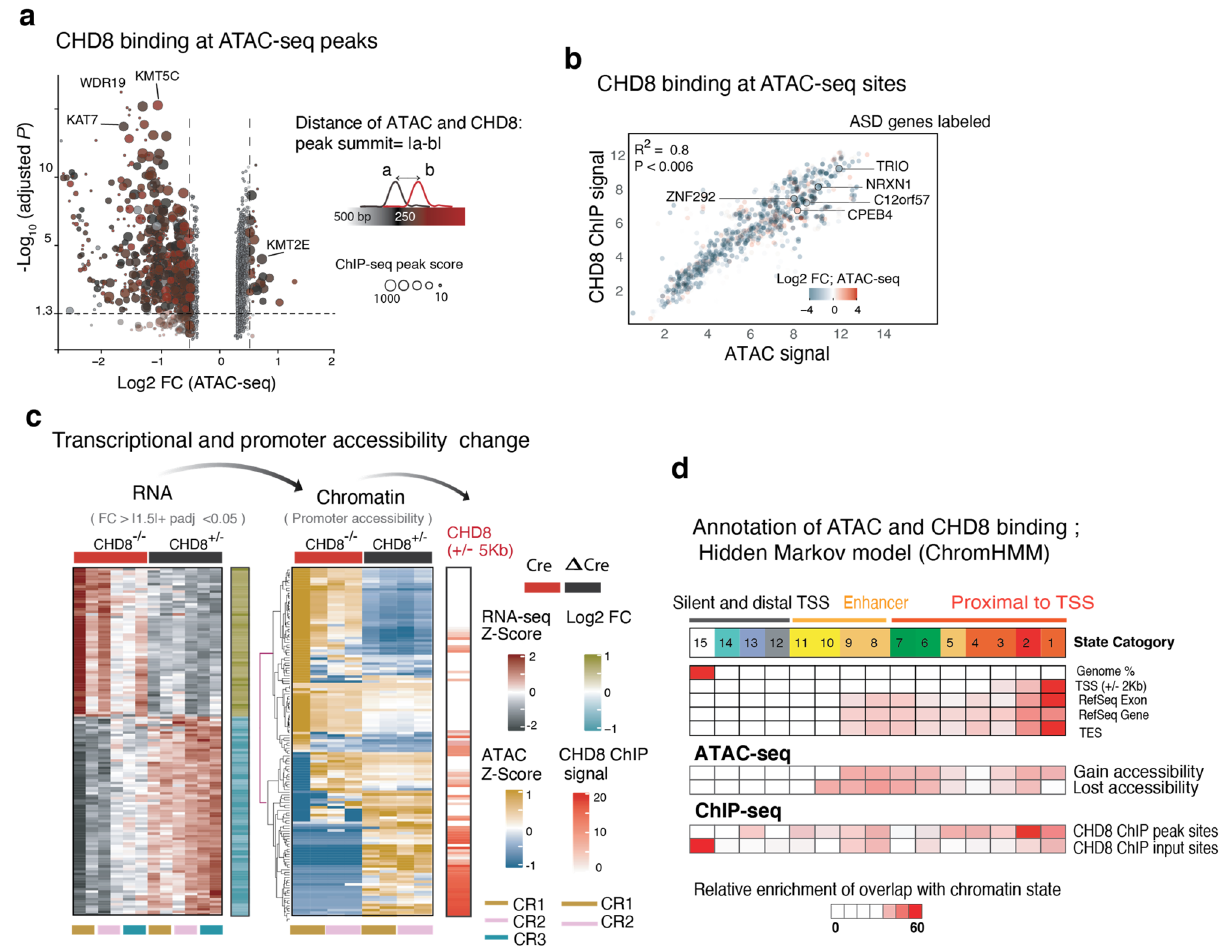
Figure 18. CHD8 induces accessible chromatin at its direct chromatin targets. ( a ) Volcano plot depicting each ATAC-seq peak as one dot. The color indicates the distance of the ATAC-seq peak summit from the CHD8 peak summit at the immediate vicinity, and the size reflects the CHD8 ChIP-seq peak score. ( b ) Linear regression of DESeq2 normalized CHD8 binding signal and DE-seq2 normalized ATAC-seq signal at the promoters of genes with change accessibility, and example ASD genes are labeled. The color indicates log2 change of the accessibility in CHD8 KO. ( c ) Analysis of chromatin modification enrichment with ChromHMM and the annotation of the genomic feature with transition probability for 15 state model uncovers the distribution and the relative enrichment of CHD8 binding and the ATAC-seq sites across all chromatin states in neurons (GEO accessions used for this analysis listed in Supplementary Table 1). ( d ) RNA-seq and ATAC-seq signal for 136 genes with a significant change in gene expression and ATAC-seq signal in KO. CHD8 binding signal sorted with the same order of the sites of the promoters at the respective